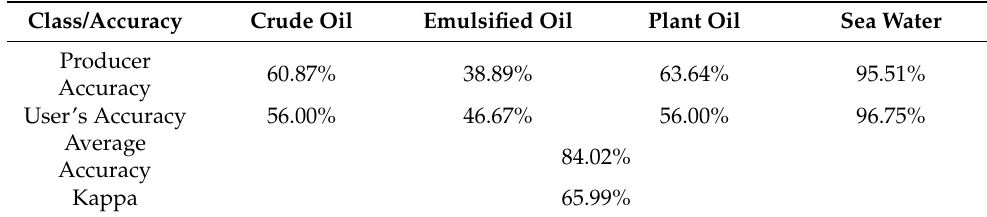
Table 5. Classification accuracies of random forest classifier in Case 3.